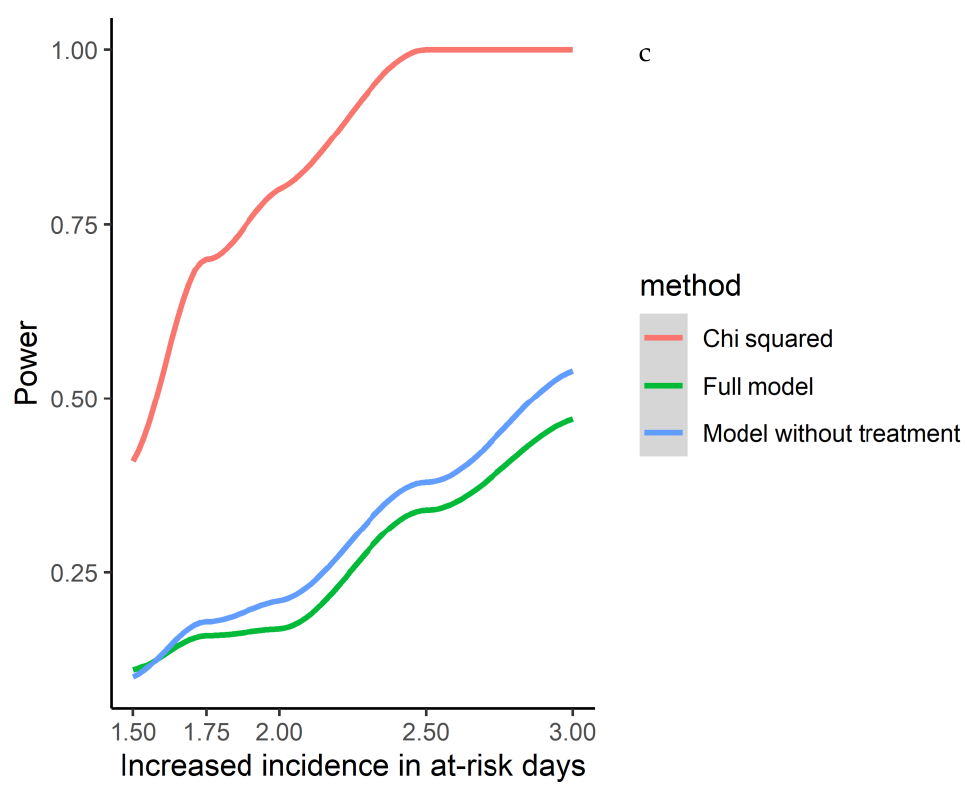
Figure 4. ( a – c ) Power analyses were calculated for the full model, for the model with correction of patient and seasonality (but no treatment), and for the basic model (chi-squared analysis).